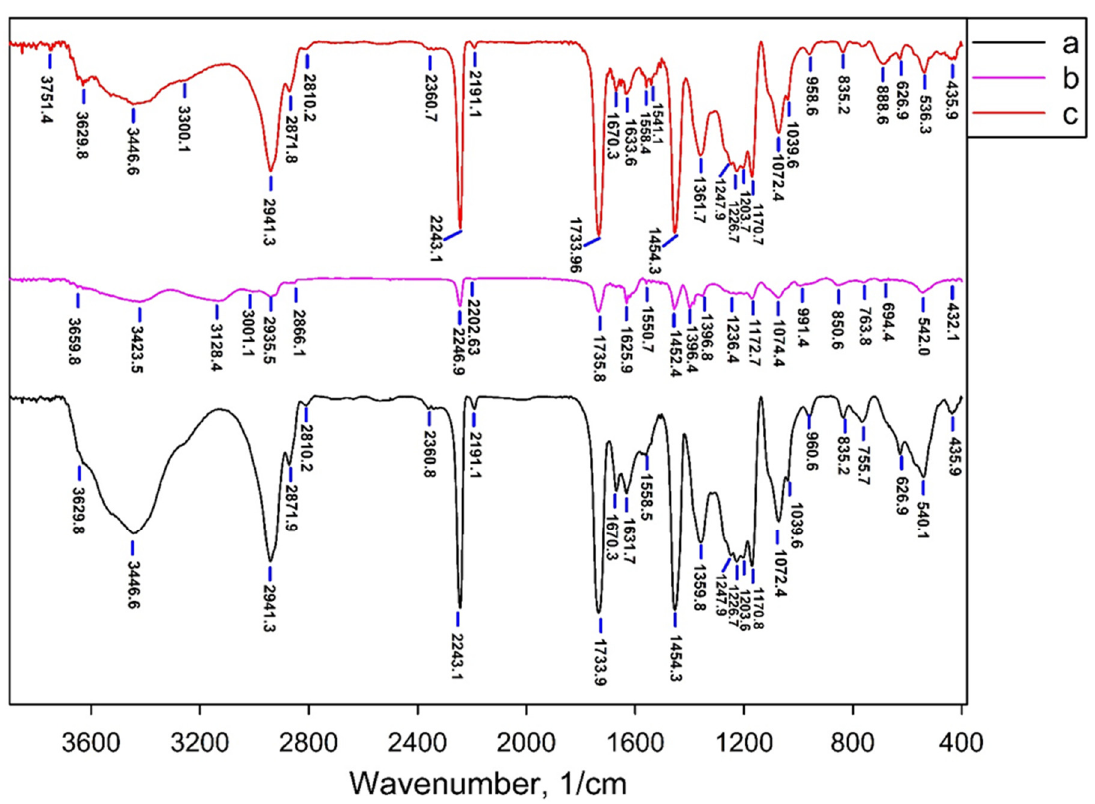
Figure 6. IR spectra of the sorbents: (a)—Fe-NH, (b)—Fe-SF, (c)—Fe-H.